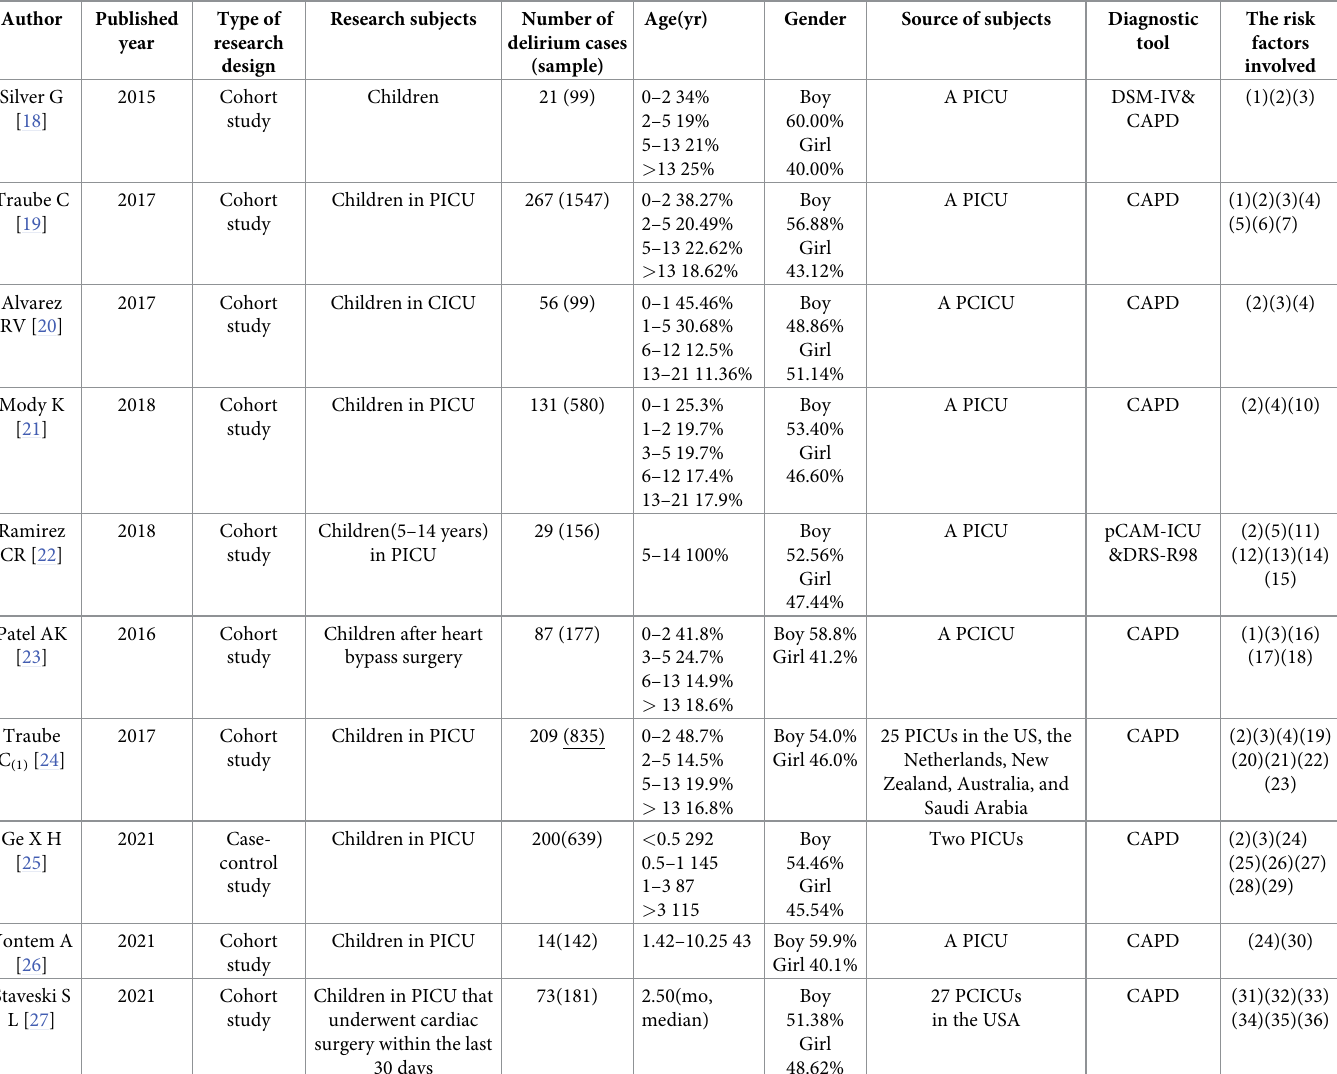
Table 1. General characteristics of included